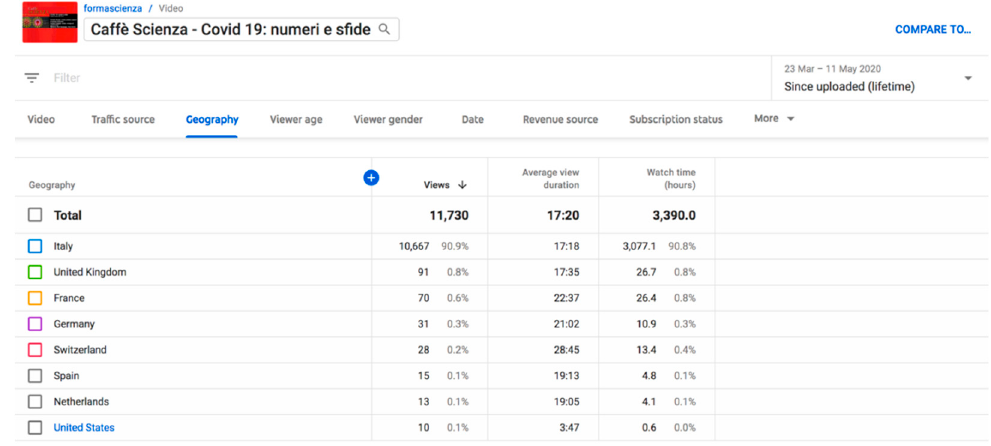
Figure 3. YouTube analytics showing geographic locations for the first Rome online science café.